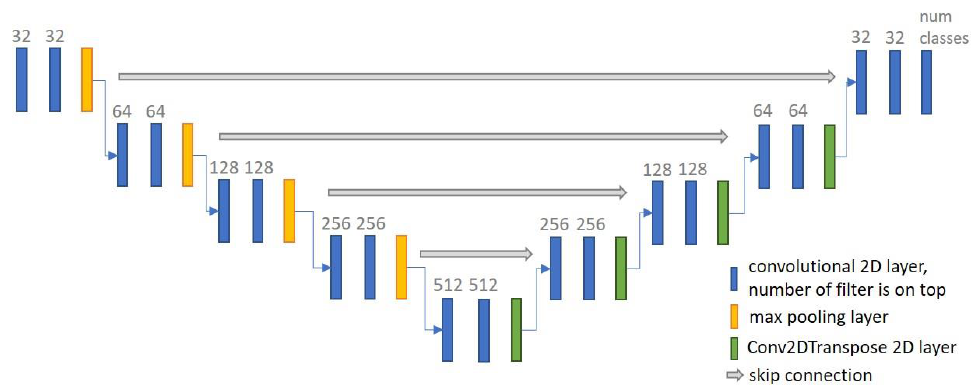
Figure 9. The U-Net architecture. Based on [17]. Features encoder and decoder paths and skip connections concatenating their outputs. Both input and output are 2D.